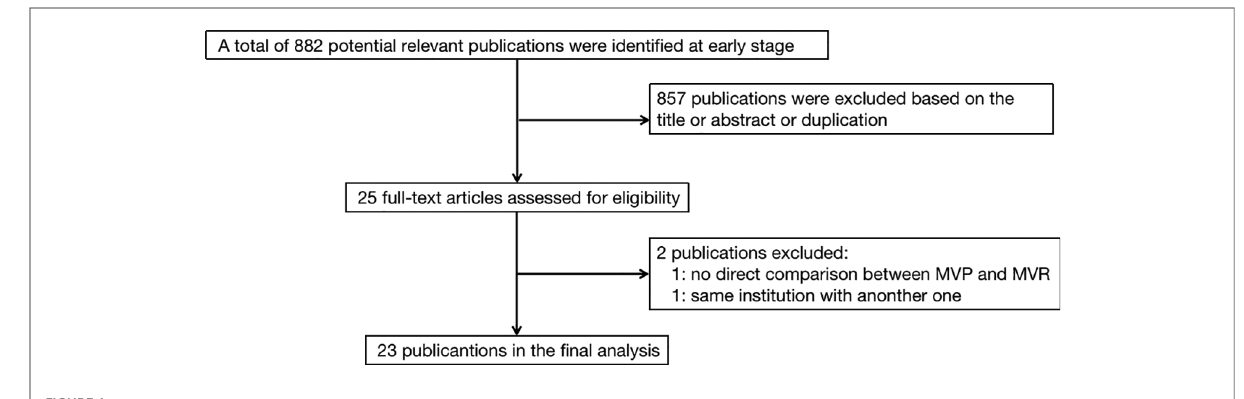
FIGURE 1 The fl owchart outlining the literature search